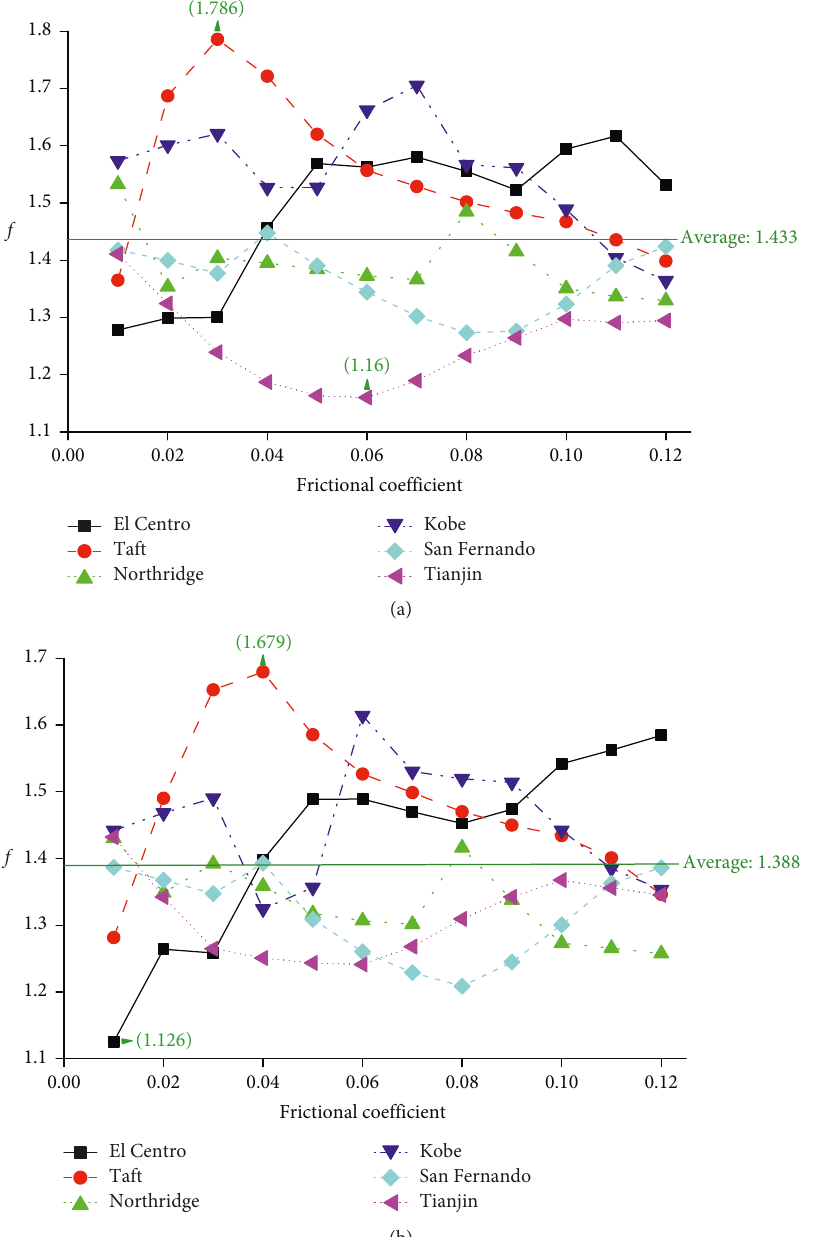
Figure 15: Comparison of the response amplitude of the pier bottom under various ground motions. (a) Shear force of the pier bottom. (b) Bending moment of the pier